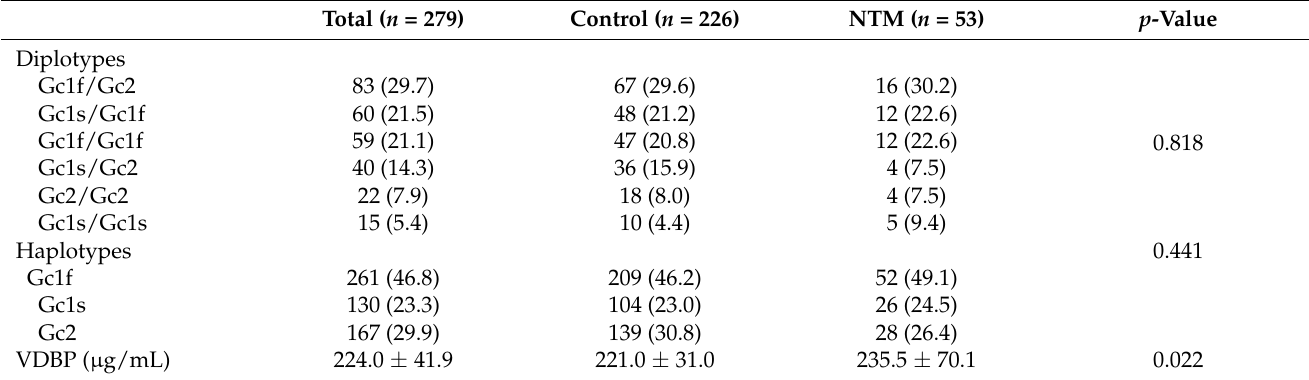
Table 2. Allele frequency of VDBP isoforms and VDBP concentrations in study subjects.